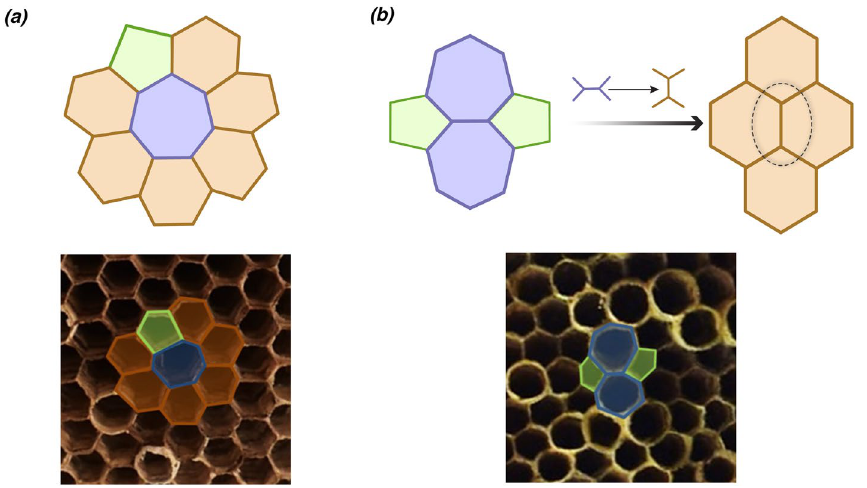
Figure 6. Schematic representation of ( a ) a pentagon and a heptagon amidst hexagons (dipole), and ( b ) Stone-Wales defect (pentagon-heptagon quadrupole) or a dislocation dipole. The arrow points towards the representation of hexagons when these defects are fixed. The possible modifications to the wall are indicated above the arrow. Bottom panels show their outline in the wasp